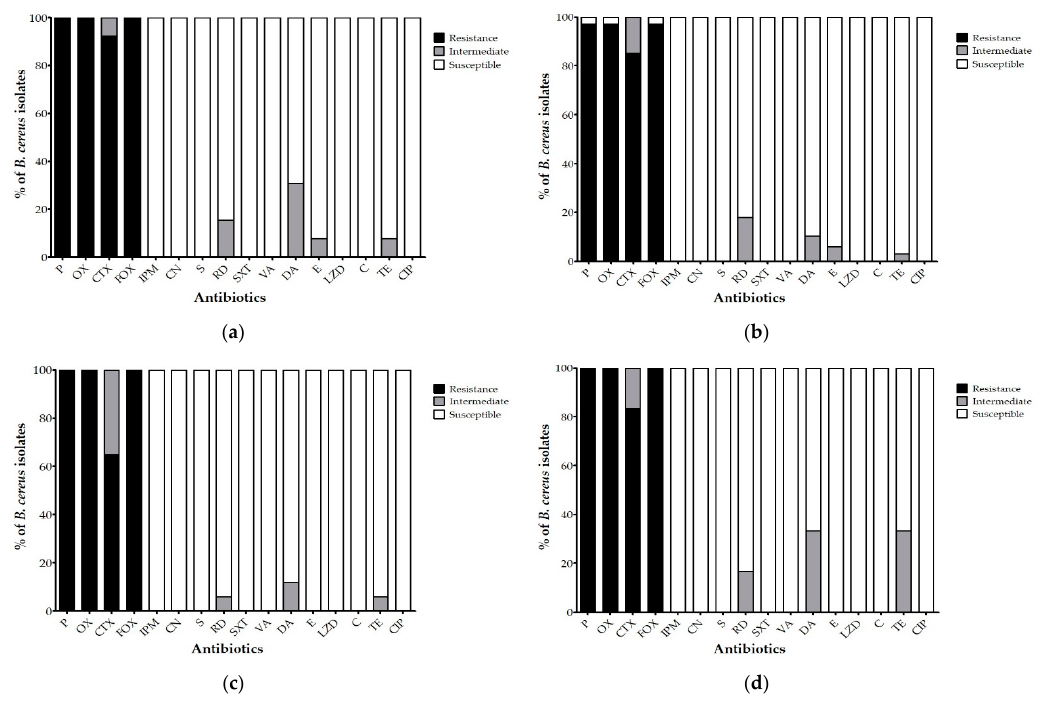
Figure 1. Antibiotic susceptibility of B. cereus isolated from garlic chives ( a ), soil ( b ), compost ( c ), and irrigation water ( d ) was determined by disk diffusion method. P, penicillin; OX, oxacillin; CTX, cefotaxime; FOX, cefoxitin; IPM, imipenem; CN, gentamicin; S, streptomycin; RD, rifampin; SXT, trimethoprim-sulfamethoxazole; VA, vancomycin; DA, clindamycin; E, erythromycin; LZD, linezolid; C, chloramphenicol; TE, tetracycline; CIP, ciprofloxacin.